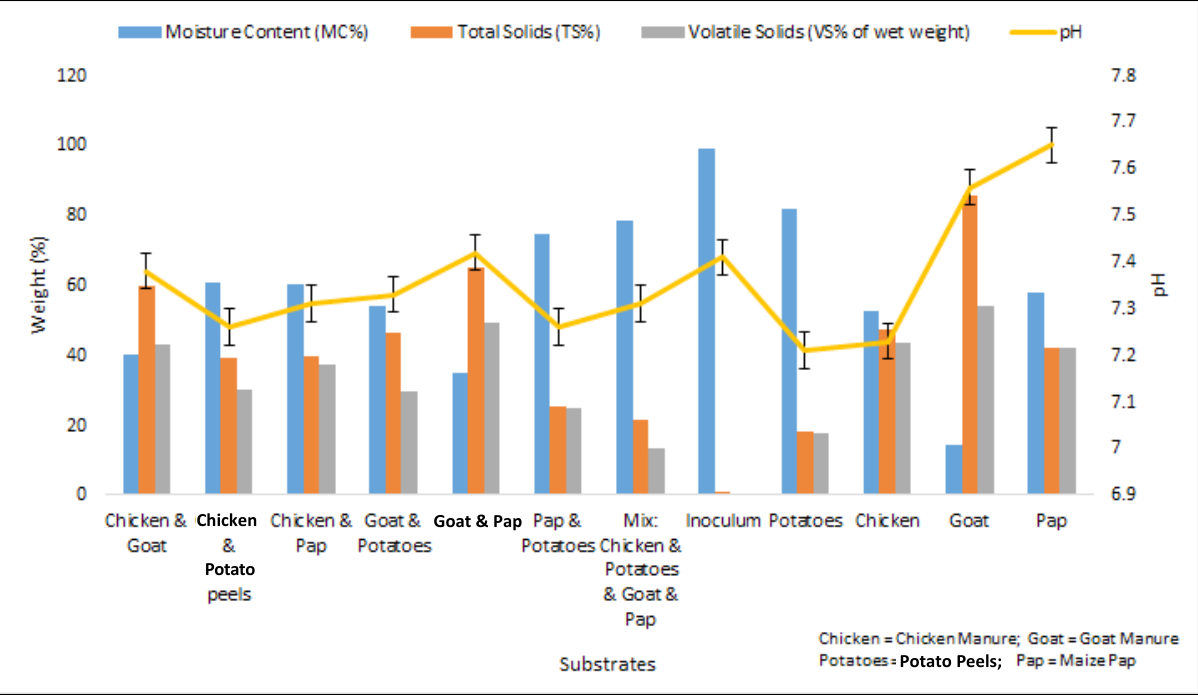
Figure 4: Results of the proximate analysis of the substrates and absolute pH on biogas